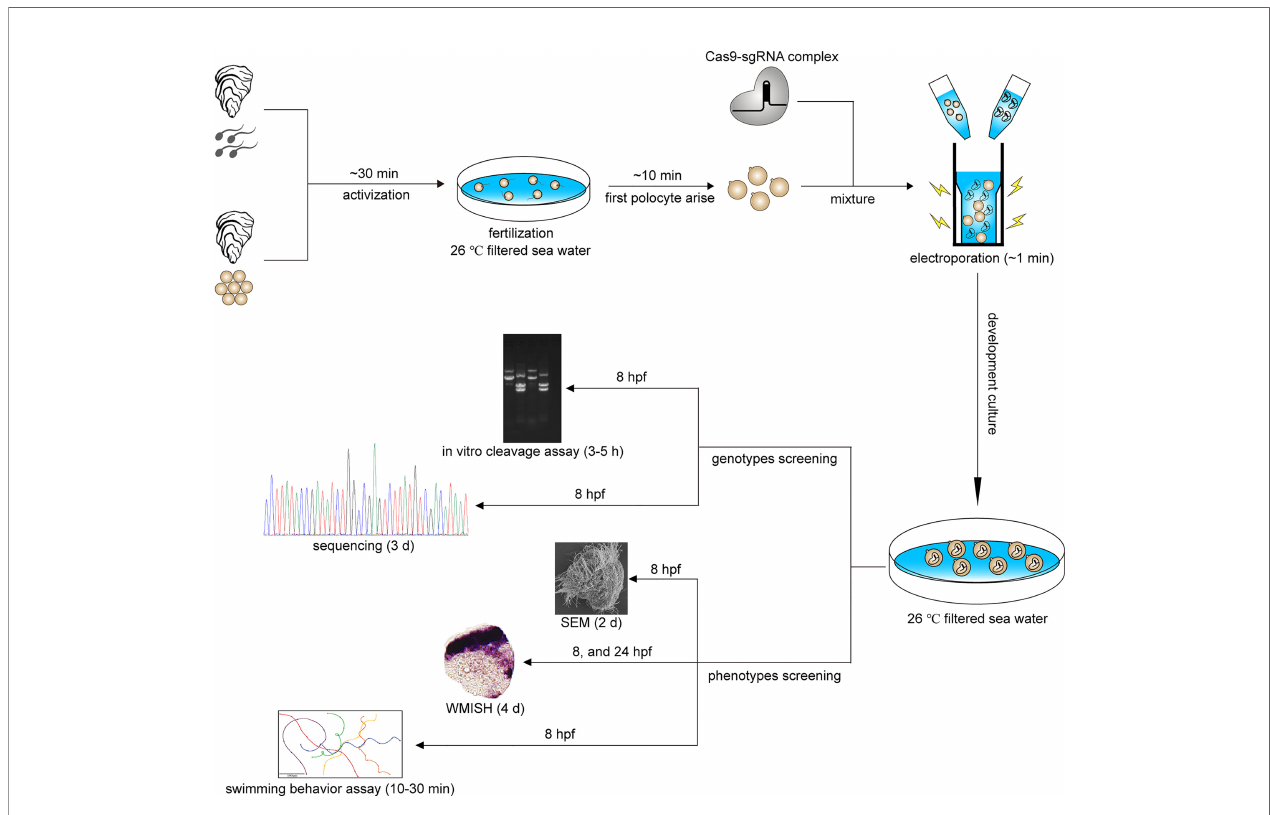
FIGURE 1 | Procedure and timeline of G 0 CRISPR/Cas9 mosaic knockout experiments in C. gigas angulate .